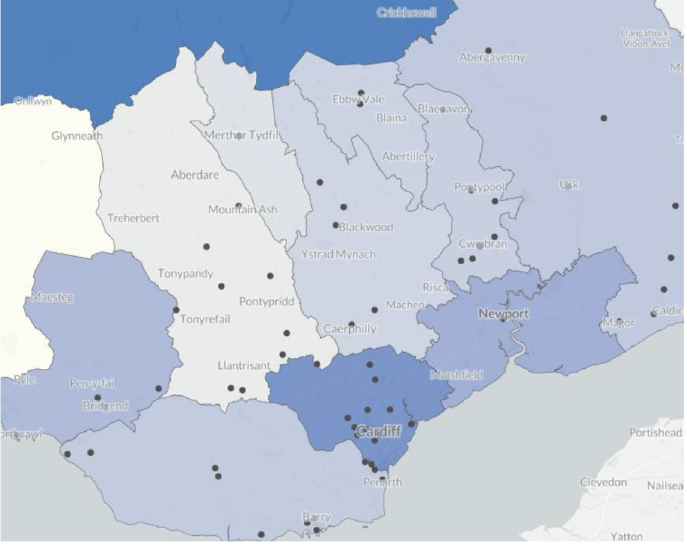
Figure 6: Community groups are marked on the map at higher zoom levels as dark grey